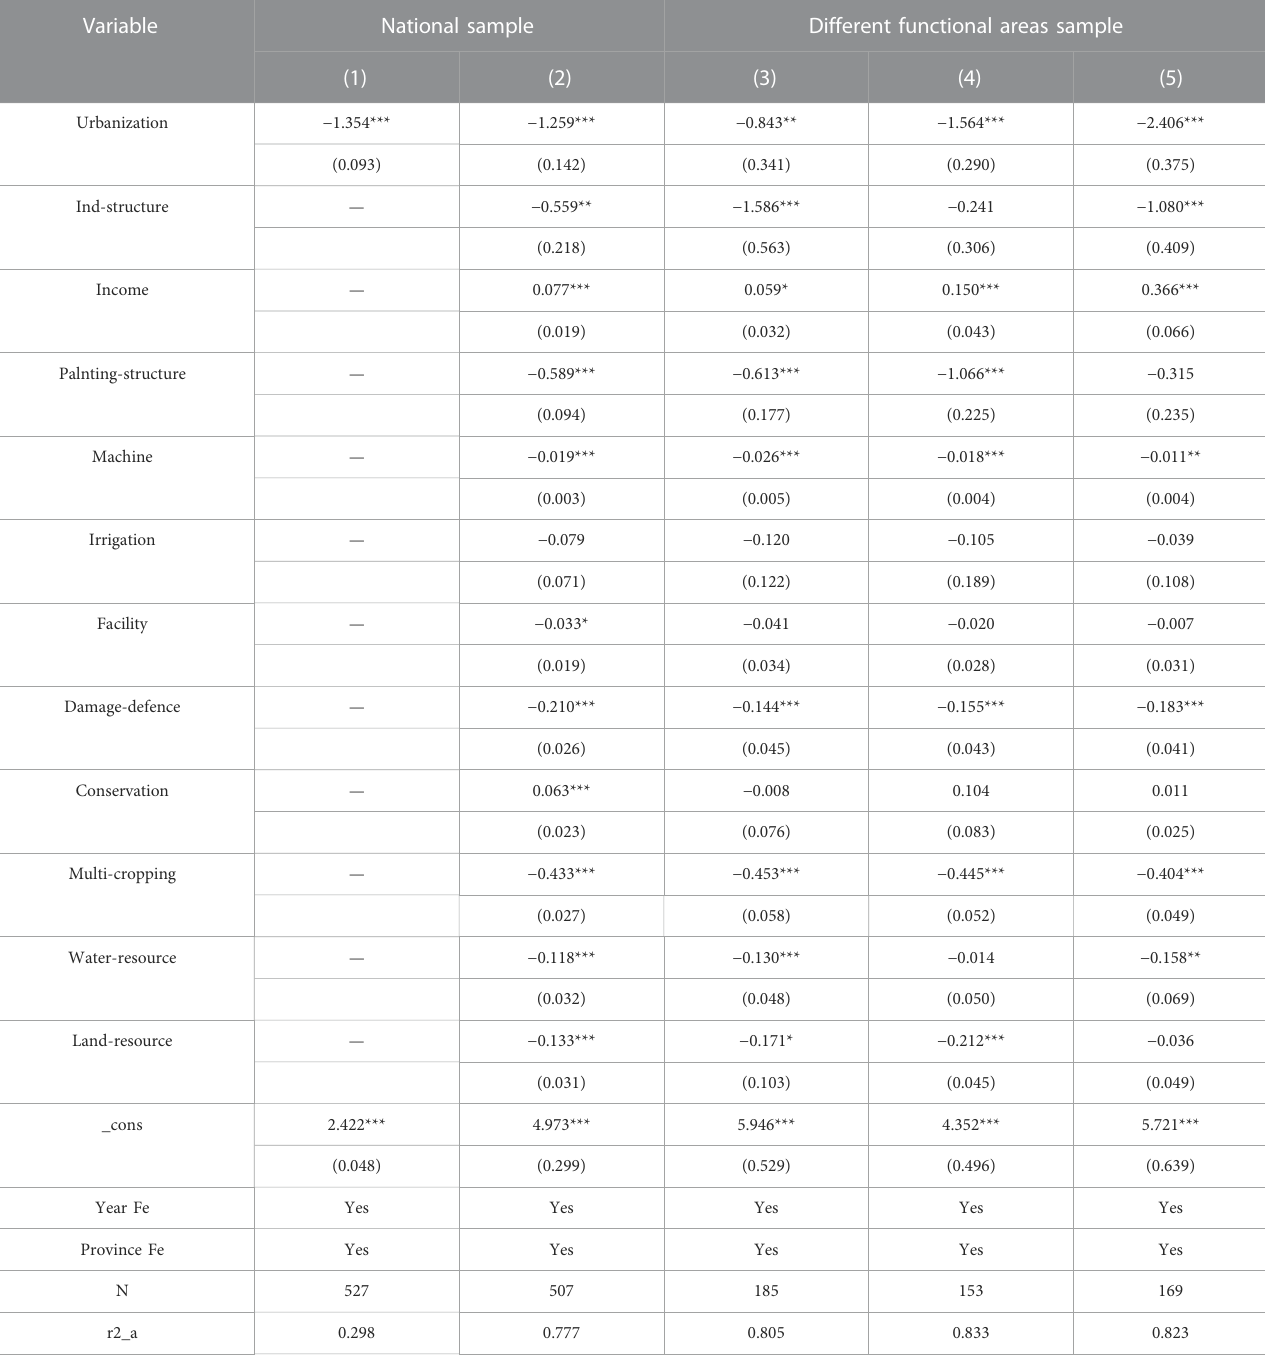
TABLE 6 Effect of urbanization on the multi-functional structure of cultivated land. Variable National